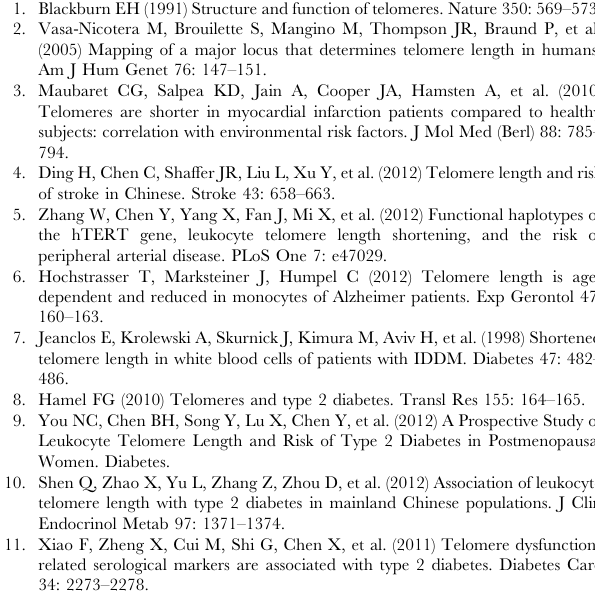
Table S1 Quality assessment of association studies between telomere length and T2DM.